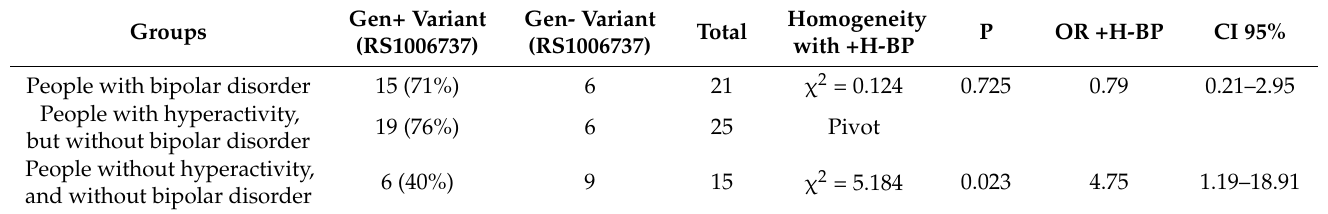
Table 2. People with hyperactivity and without bipolar disorder (+H-BP) are homogeneous as regards the frequency of variant RS1006737 in the people with bipolar disorder (+BP) but not the people without hyperactivity and without bipolar disorder